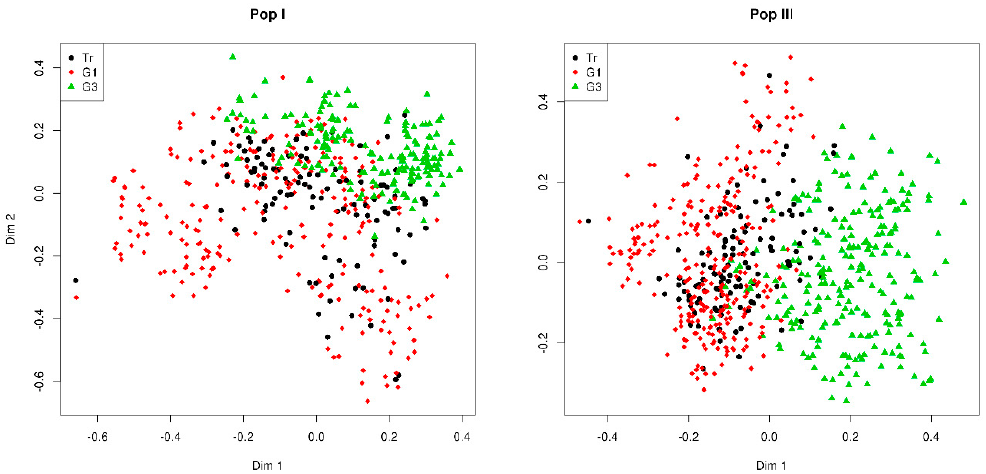
Figure 1. Multi-dimensional scaling (MDS) plot based on the distance metric (1-GRM) for Pop I and Pop III training generation (Tr) and selection (G1 and G3) populations. Note that the full training set used to derive the prediction models contained three additional populations (Pop II, IV, and V), which are not represented in these figures.